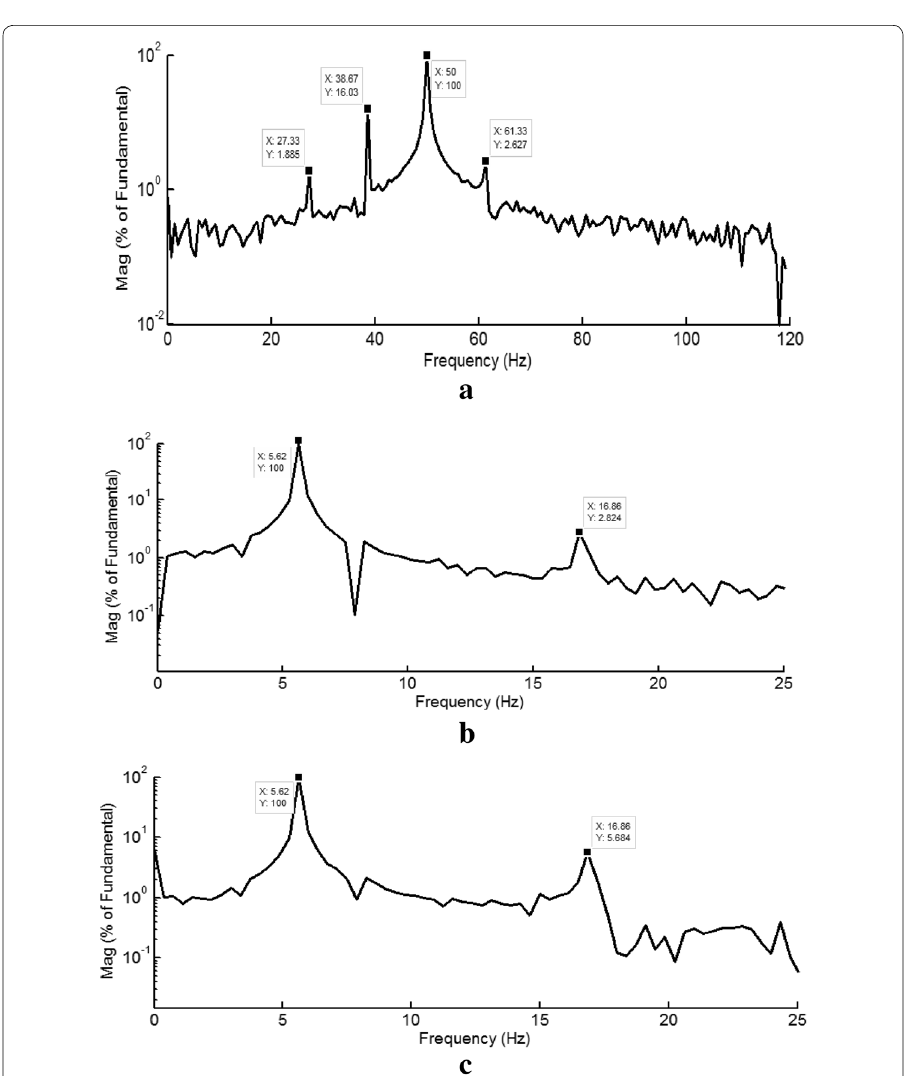
Fig. 15 Current spectrum for delta connection with reversed one phase and external open circuit, a stator phase current, b rotor (phase‑ar) current and c rotor (phase‑br)